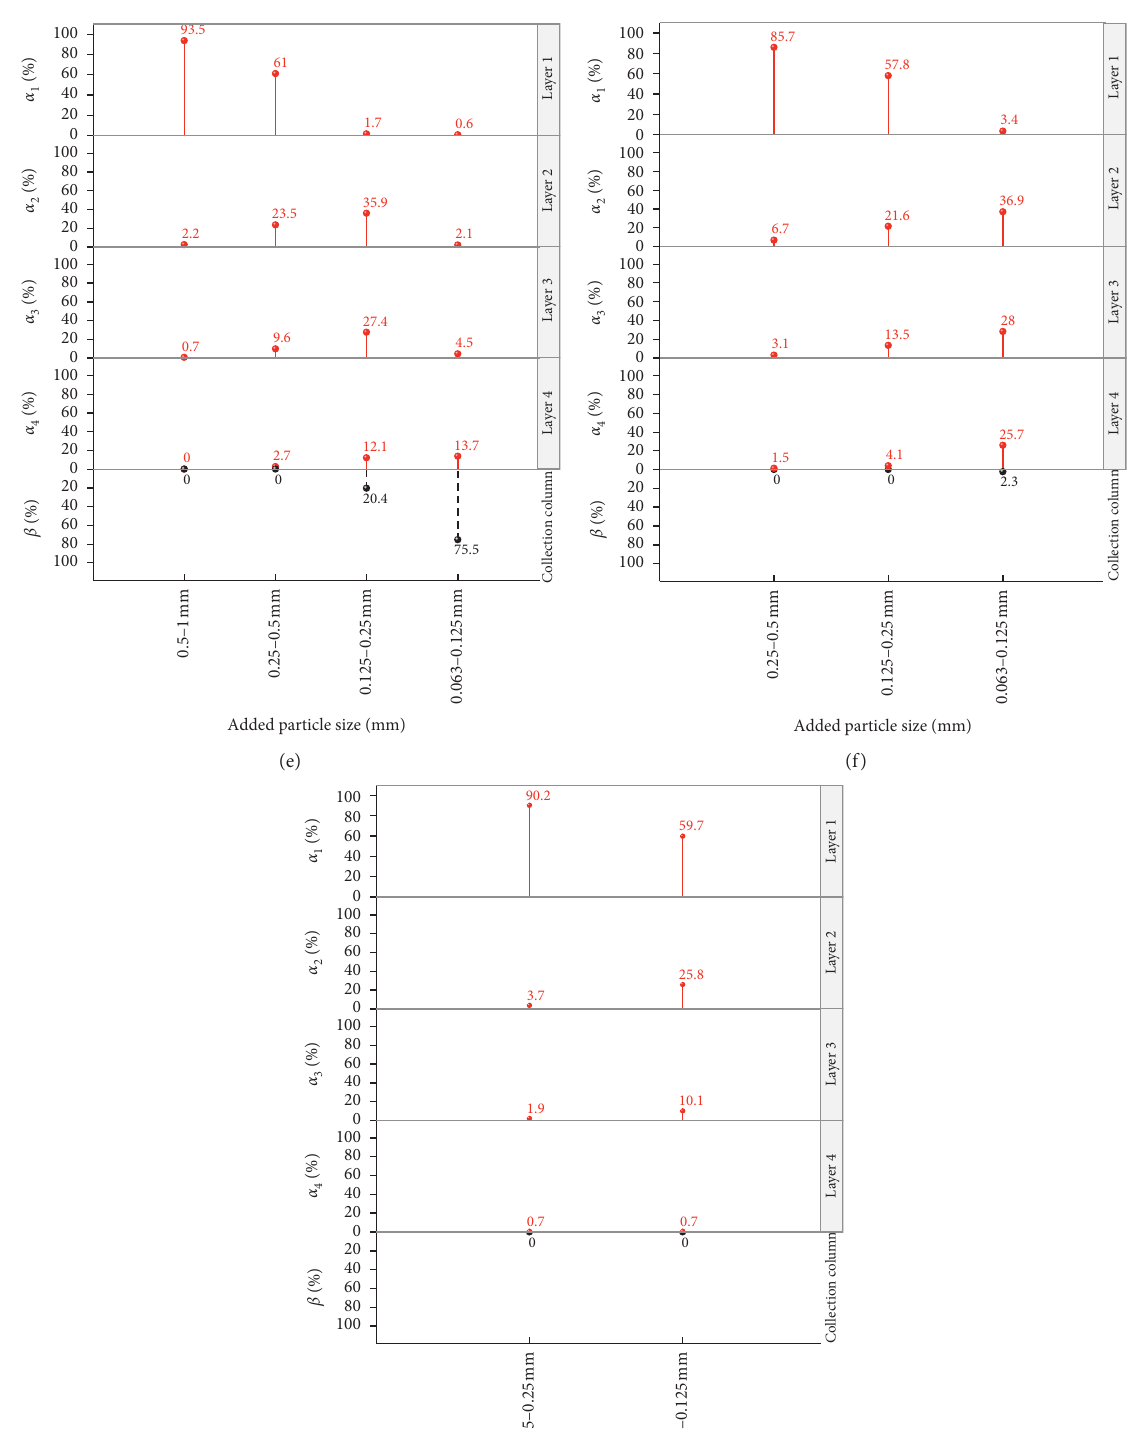
Figure 5: Mass percentage of clogging particles in four layers and loss in the collection column in six groups of soil media samples. (a) Soil media PSs of 32–64 mm. (b) Soil media PSs of 16–32mm. (c) Soil media PSs of 8–16 mm. (d) Soil media PSs of 4–8 mm. (e) Soil media PSs of 2–4mm. (f) Soil media PSs of 1–2 mm. (g) Soil media PSs of 0.5–1mm. α i � ( m i / m some size in layer I, kg; m 0 is the total mass of incoming particles of some size, kg; β � ( m m / m particles of some size in the collection column,